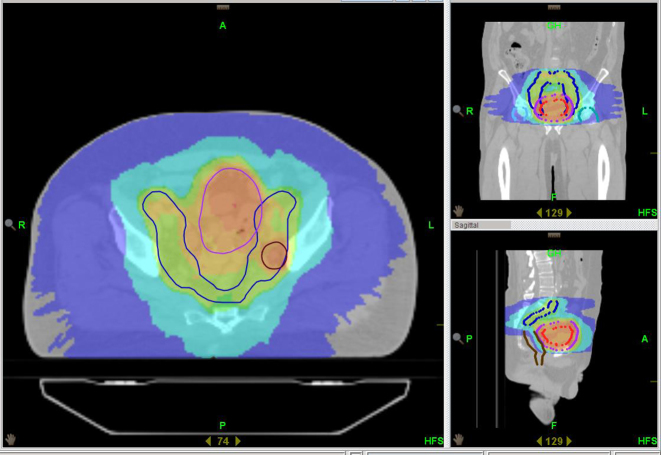
Tomotherapy plan.